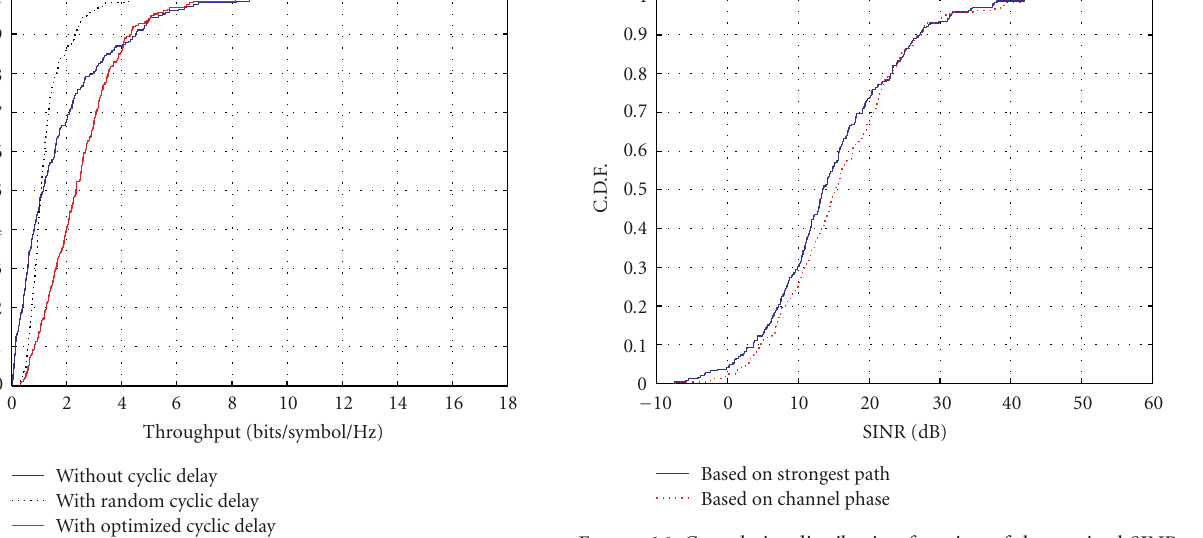
Figure 14: Normalized system throughput on an urban environ- ment with a cell radius of 500 m.